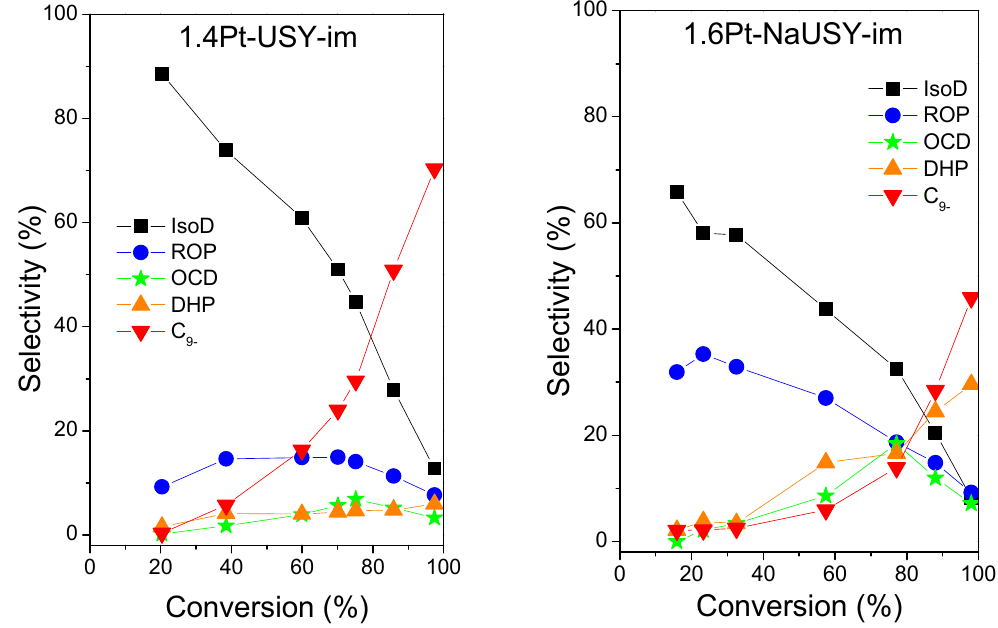
Figure 4. Productselectivities(%)vs. decalinconversion(%)obtainedfor1.4Pt-USY-imand1.6Pt-NaUSY-im Figure 4. Product selectivities (%) vs. decalin conversion (%) obtained for 1.4Pt-USY-im and 1.6Pt- catalysts. Reaction conditions: T = 300–390 ◦ C, WHSV = 3.22 h − 1 , P = 35 bar, and H 2 / D = Table 5. Maximum selectivities of OCDs obtained for 1.4Pt-USY-im and 1.6Pt-NaUSY-im catalysts.